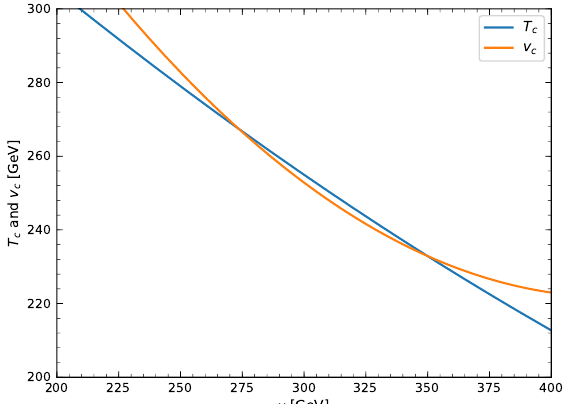
Figure 17 . T c and v c as functions of (cid:22) , with w ( v ) = 972 : 7 GeV, m S ( v ) = 655 : 9 GeV, m (cid:31) ( v ) = 460 : 0 GeV, and (cid:18) ( v ) = 0 :